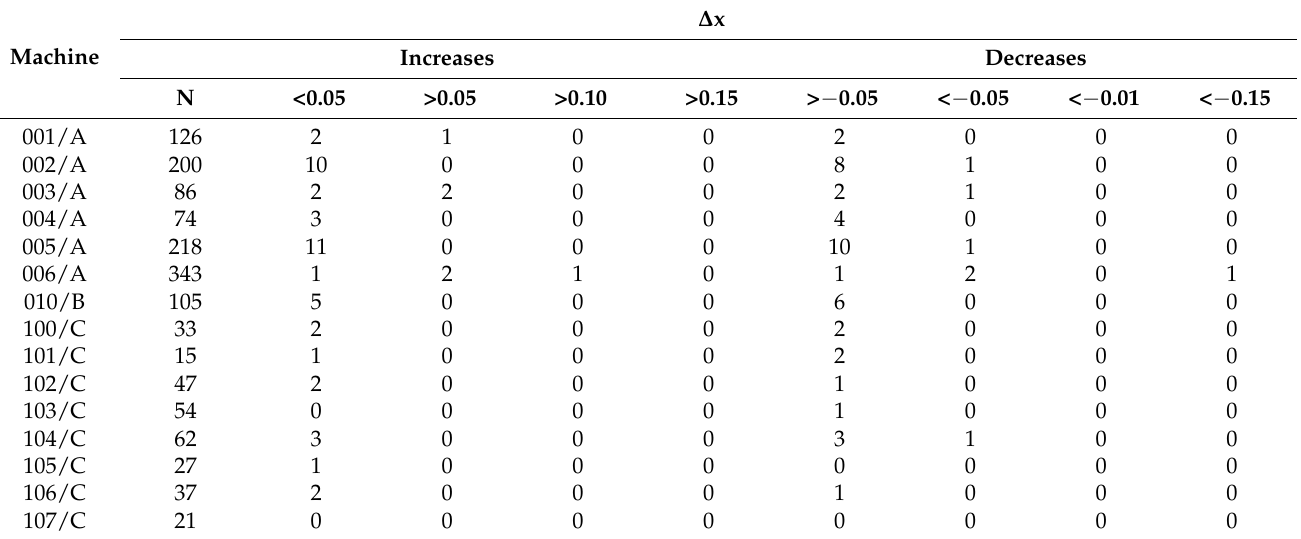
Table 1. Statistics of the difference in entropy for all